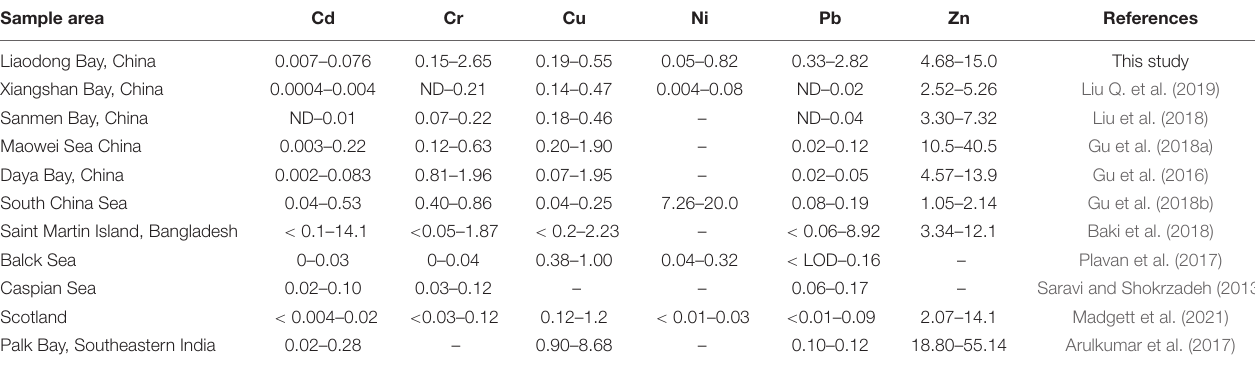
TABLE 2 | Comparison of trace metal concentrations ( µ g/g, wet weight) in marine fish collected from Liaodong Bay and other areas. Sample